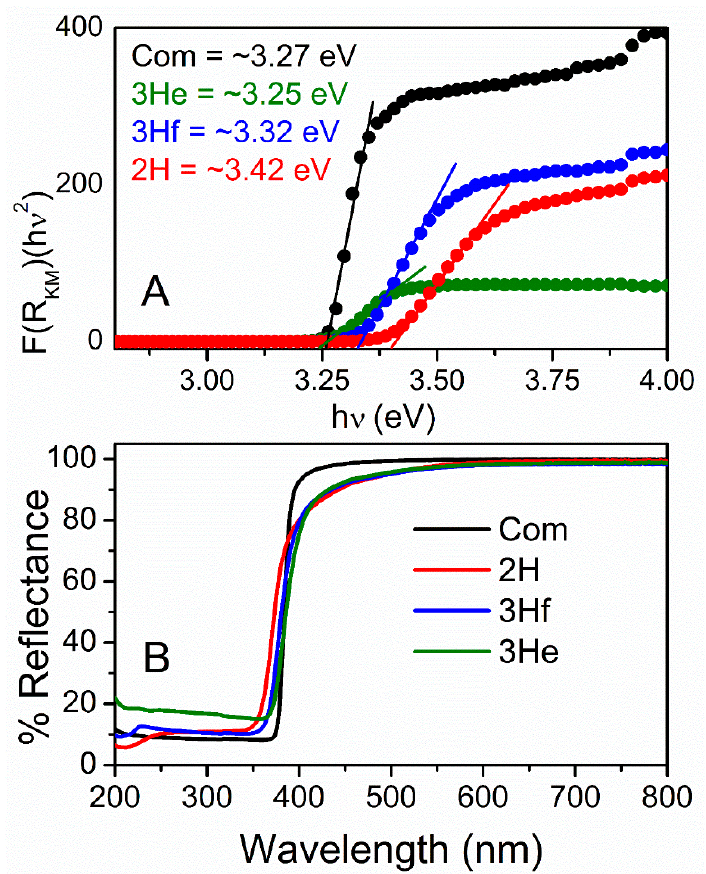
Figure 5. Kubelka–Munk function versus bandgap energy ( A ) calculated from UV–Vis diffusive reflectance spectra ( B ) for commercial ZnO (black) and synthesized by bipolar electrochemistry (2H—red, 3H filtrated blue and 3H evaporated—green).